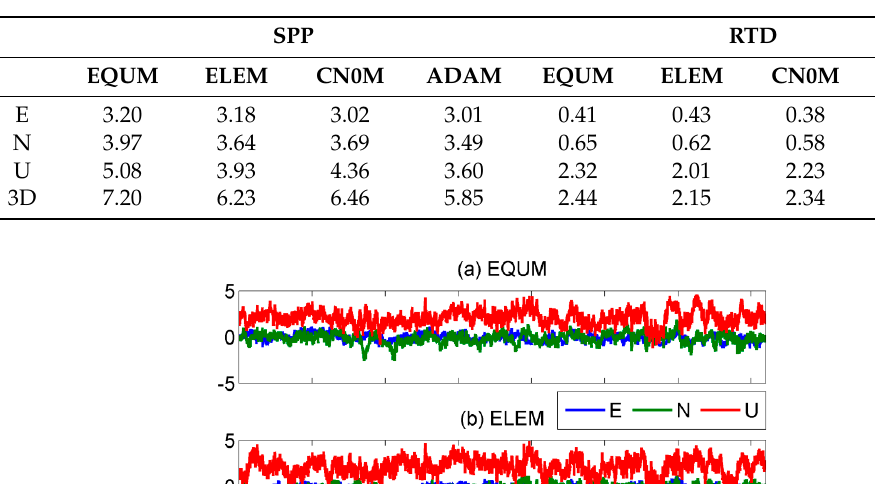
Figure 12. Positioning differences between the SPP solutions and the precise coordinates of dataset no. 2. ( a ) Results of the equal-weight model (EQUM); ( b ) results of the elevation model (ELEM); ( c ) results of the C/N0 model (CN0M); and ( d ) results of the adaptive model (ADAM). Table 2. Statistical results of SPP and RTD using the equal-weight model (EQUM), elevation model (ELEM), C/N0 model (CN0M), and adaptive model (ADAM). The RMS values of E, N, and U directions, and 3D RMS values were calculated from dataset no. 2 (m).